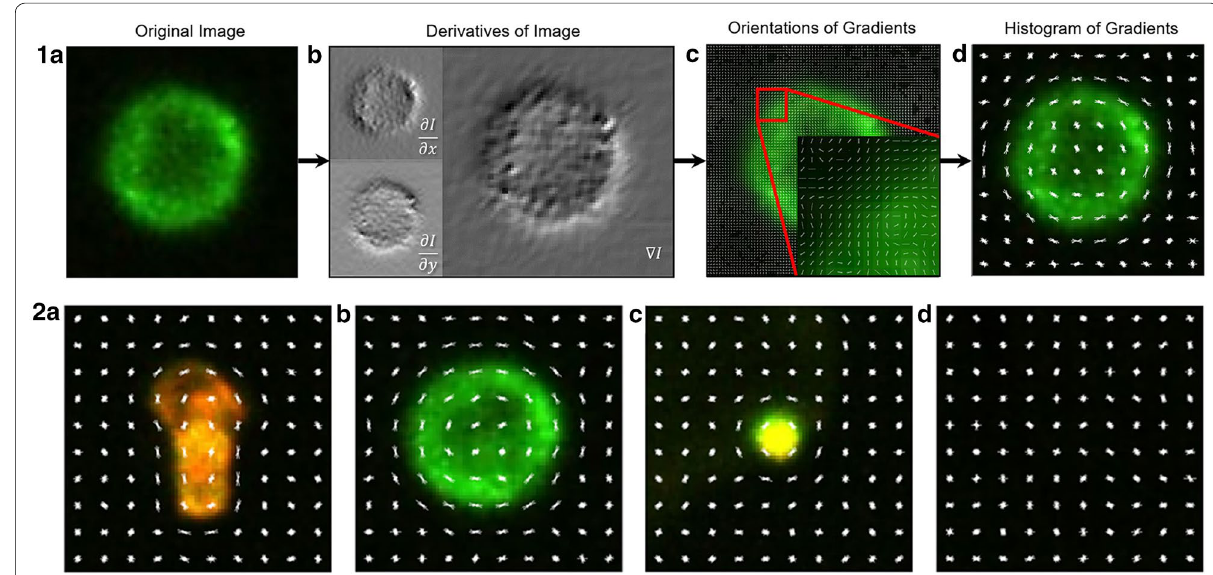
Fig. 4 Original image 1 (a), horizontal and vertical derivatives of image 1 (b), orientations of gradients overlaid on each pixel 1 (c), orientations gathered into histograms and block normalized 1 (d). Histogram of gradient features overlaid on cells 2 (a, b), noise 2 (c) and background image 2